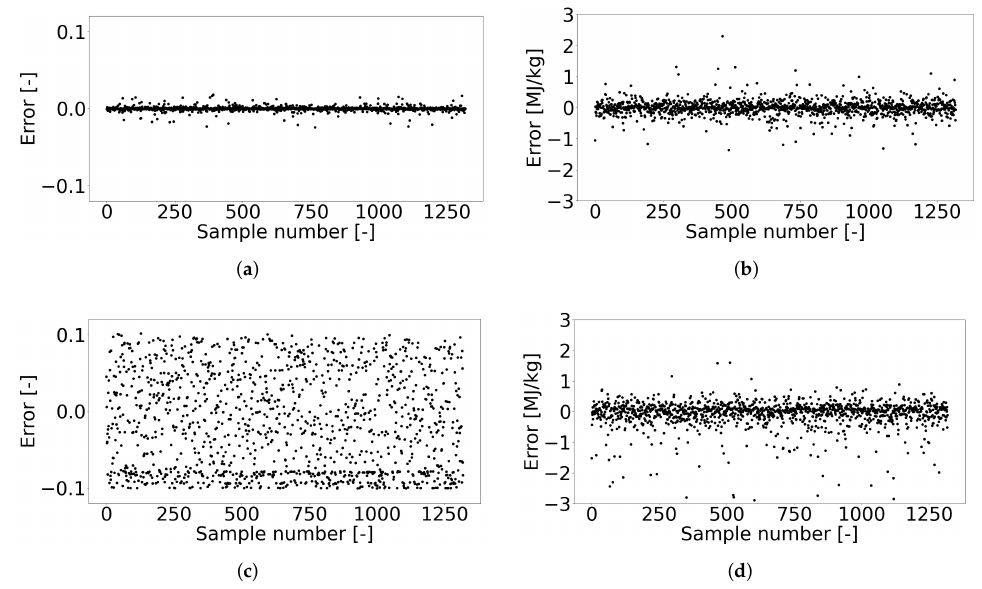
Figure 6. Plots of errors for model prediction. ( a ) Error of capture rate prediction (XGBoost). ( b ) Error of SRD prediction (XGBoost). ( c ) Error of capture rate prediction (SVR). ( d ) Error of SRD prediction (SVR). All errors for model prediction are based on original